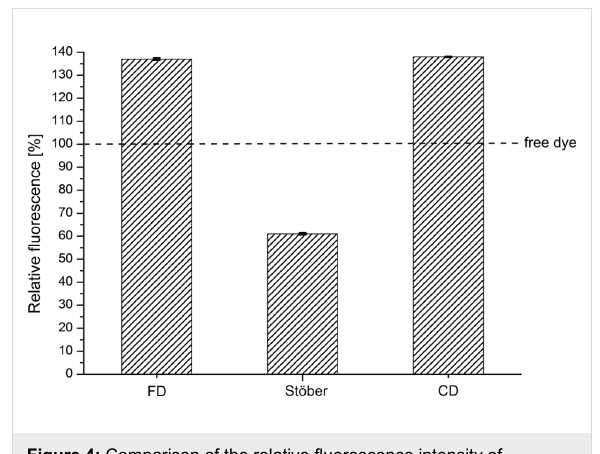
Figure 4: Comparison of the relative fluorescence intensity of FD15_Atto647N, Stoe15_Atto647N and CD_Atto647N. All samples were diluted to an absorption intensity of A = 0.012 to ensure an iden- tical number of dye molecules. The fluorescence intensity of free Atto647N–CS–APTES was set to 100%. FD15_Atto647N and CD_Atto647N exhibited a significantly higher relative fluorescence in- tensity, whereas Stoe15_Atto647N was much less brighter